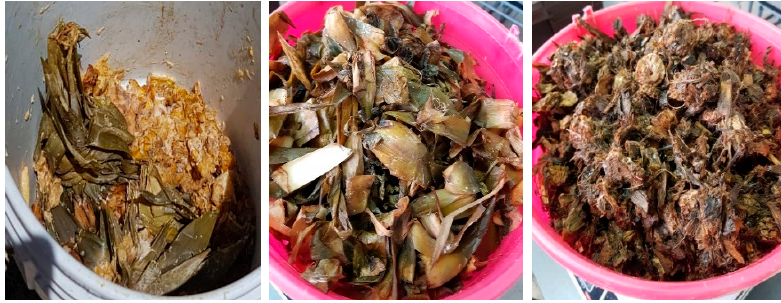
Figure 4. Evolution of pineapple waste during pre-composting.